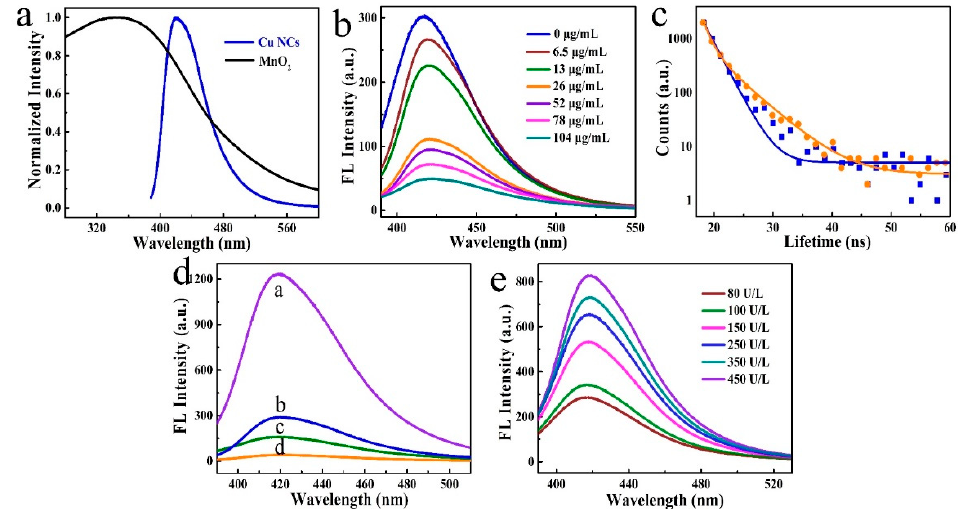
Figure 3. ( a ) Fluorescence emission (blue line) of Cu NCs and UV-visible absorption spectra of MnO 2 nanosheets; ( b ) Fluorescence spectra of Cu NCs after adding different concentration of MnO 2 nanosheets; ( c ) Fluorescence decay curves of Cu NCs with (yellow line) and without (blue line) adding MnO 2 nanosheets; ( d ) Fluorescence spectra of the combination of Cu NCs ( b ), Cu NCs/MnO 2 nanosheets ( d ), Cu NCs/MnO 2 nanosheets + BChE ( a ), and Cu NCs/MnO 2 nanosheets + BChE + OPs ( c ); ( e ) Fluorescence spectra of the detection platform by adding different concentrations of OPs. All the emission spectra were collected under the excitation of 380 nm.